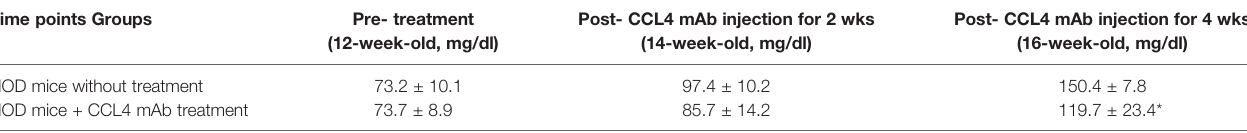
Post- CCL4 mAb injection for 2 wks (12-week-old, mg/dl) (14-week-old, mg/dl)